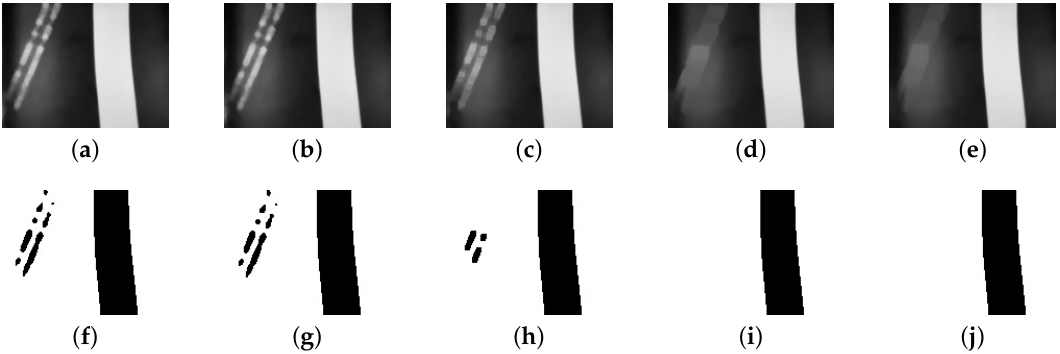
Figure 10. Comparison of different kernel sizes and its impact on noise elimination. The first row shows gray-scale blurred images with distinct opening operations: ( a ) no opening operation; ( b ) kernel size: 2 × 2; ( c ) kernel size: 5 × 5; ( d ) kernel size: 10 × 10; ( e ) kernel size: 15 × 10. The second row shows, respectively, images after a fixed threshold binarization.